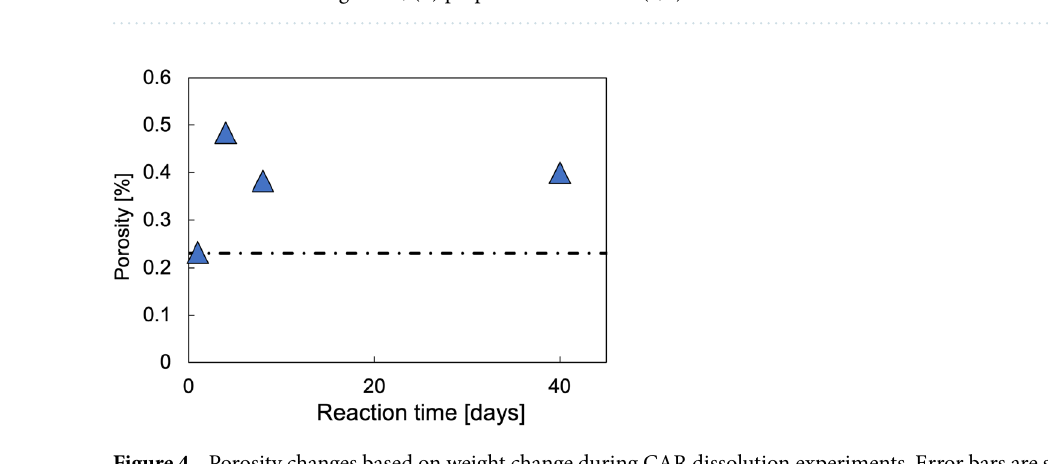
Figure 3. SEM-BSE images of CM and CAR showing. ( a ) straight cracks which are unlikely pre-existing and coincidence with siderite growth, ( b ) perpendicular cracks. ( c , d ) siderite nucleation on dolomite.